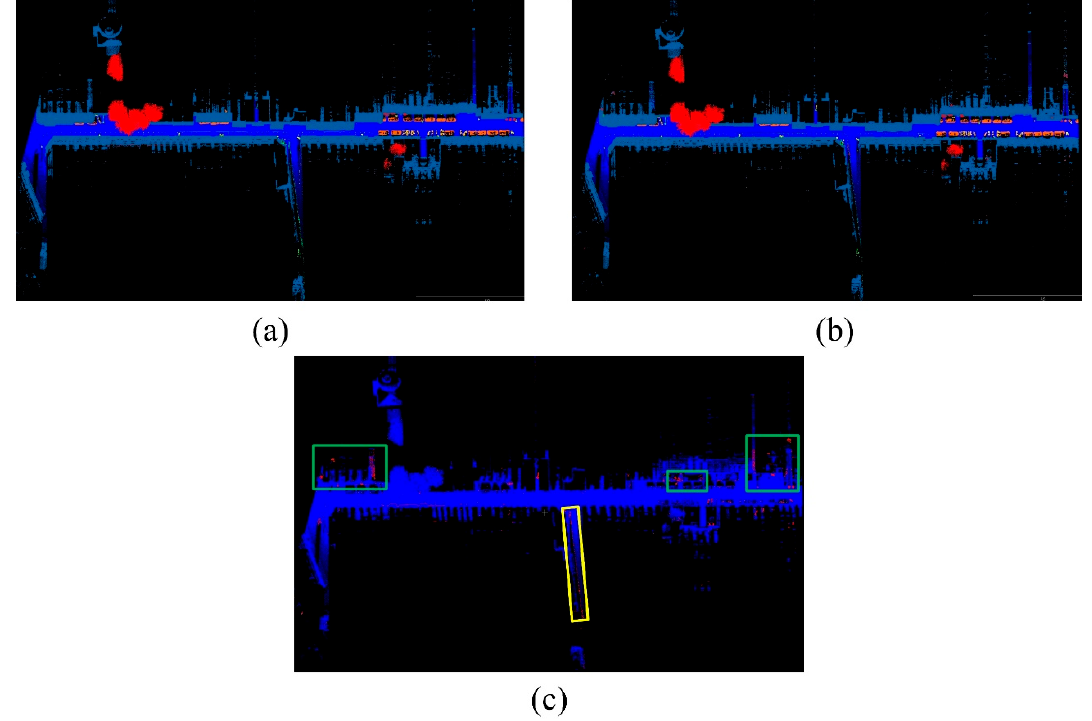
Figure 9. Classification in the Paris-rue-Cassette dataset. ( a ) Truth-ground of Paris-rue-Cassette dataset. ( b ) Classification results of the proposed method. ( c ) Incorrect classification.